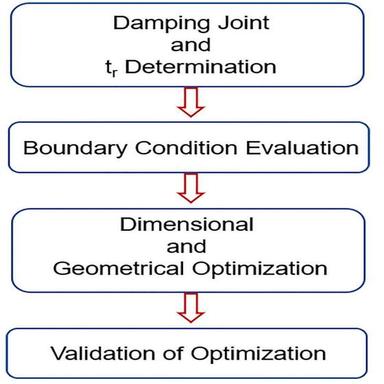
Optimization steps via ABAQUS FE.